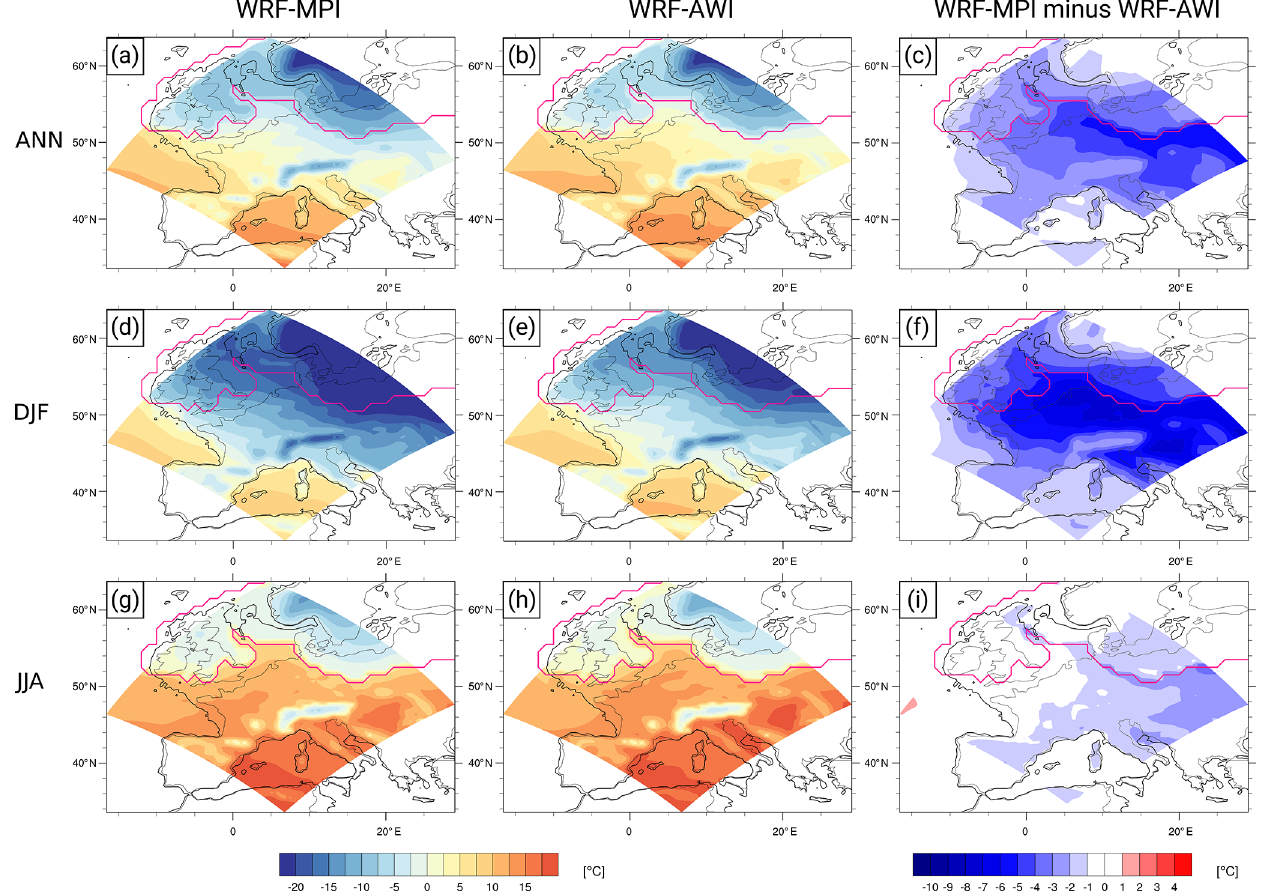
Figure 3. Distribution of 2m air temperature in annual (a–c) and seasonal winter (d–f) and summer (g–i) means as simulated with the regional WRF model with MPI forcing ( a , d , and g ) and with AWI forcing ( b , e , and h ) as well as their differences ( c , f , and i ). The black line shows the LGM coastline, and the pink line denotes the LGM ice